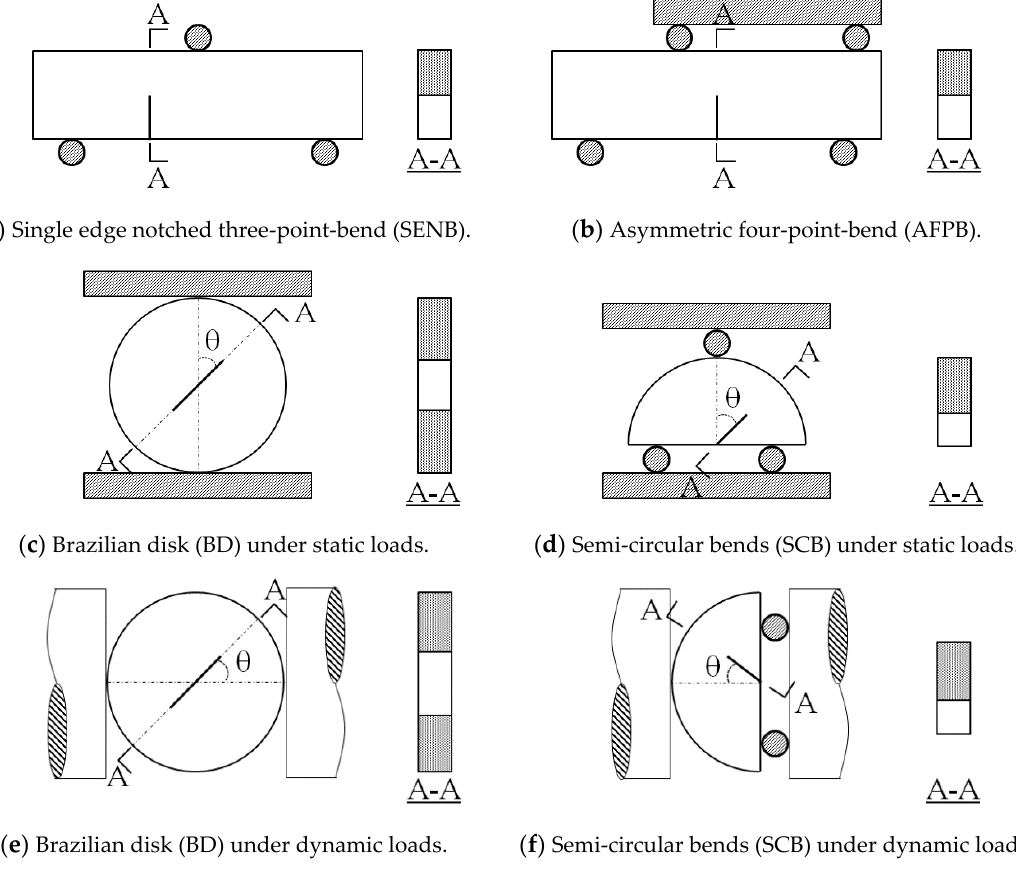
( c ) Brazilian disk (BD) under static loads. ( d ) Semi-circular bends (SCB) under static loads.